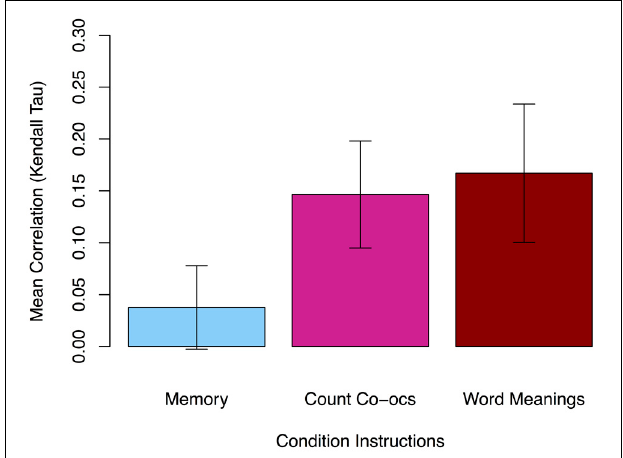
FIGURE 2 | Mean rank correlation (i.e., Kendall’s τ ) of participants’ responses with the actual pair co-occurrences in Experiment 1. The count co-occurrence and learn word meanings instructions produced larger correlations than the memory instructions. Error bars show 95% confidence intervals